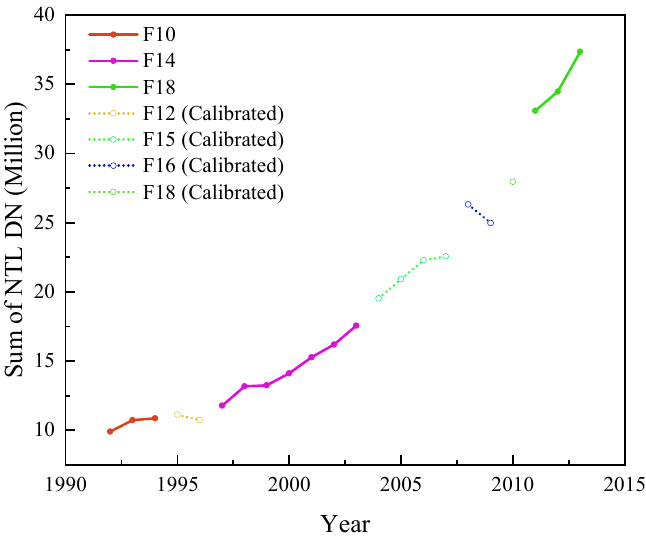
Figure 7. The trend of the total DN value of lit pixels in the reconstructed nighttime light dataset. According to the two principles in the method, combined with the relationship be- tween the development of urbanization and the nighttime light brightness in China, we found that the reconstructed nighttime light data set did not conform to the principles for some years. In order to ensure the continuity and stability of the reconstructed nighttime light dataset, the continuity calibration at the pixel scale was performed as in Equation (2):